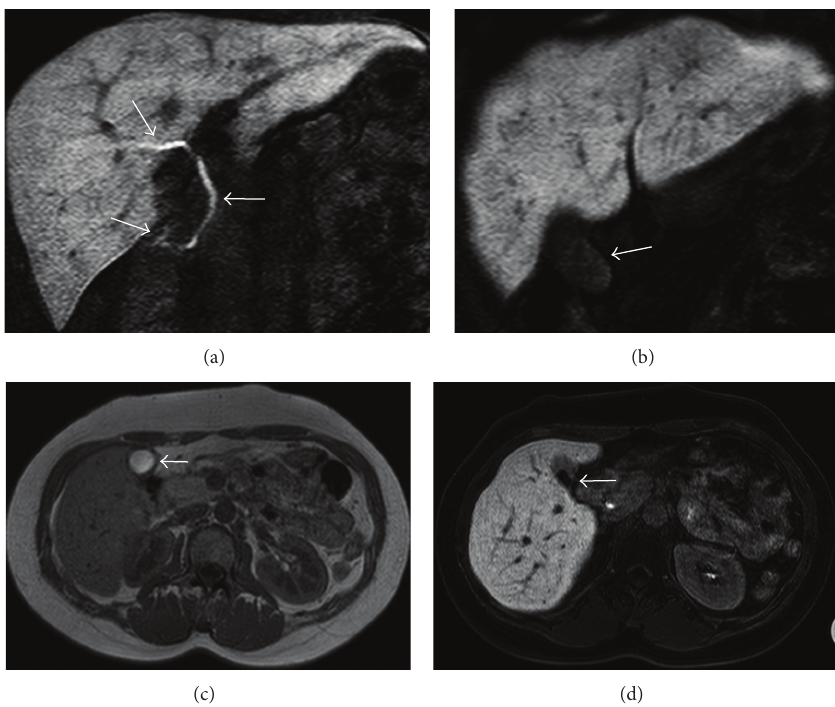
Figure 2: Delayed type of bile accumulation in gallbladder in a 37-year-old female with chronic hepatitis associated with type C viral hepatitis. On coronal hepatobiliary phase (HP) obtained 12 min after administration of Gd-EOB-DTPA, MR cholangiography demonstrates excretion of contrast media in intrahepatic duct to duodenum (a) (arrows). However, there is no accumulation of contrast media in gallbladder even in coronal 20 min HP image (b) (arrow). This patient had both T1 hyperintense bile on transverse in-phase fast spoiled gradient-echo T1 weighted image (c) (arrow) and gallbladder stone on transverse 20 min HP image (d)